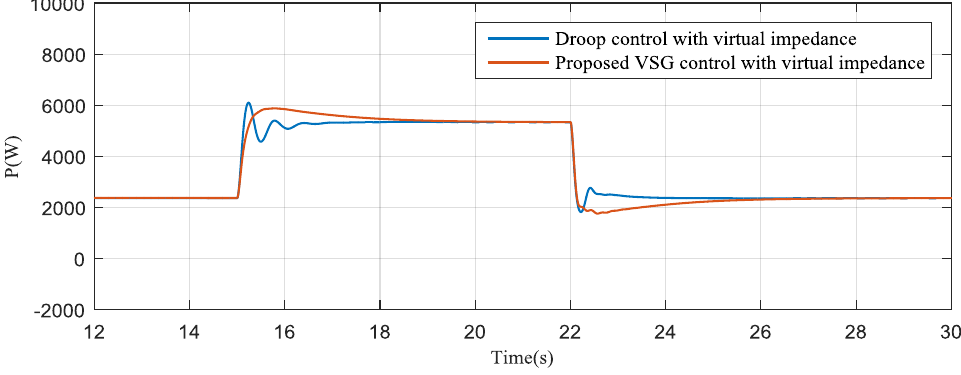
Figure 24. Active power of the grid-forming converter.